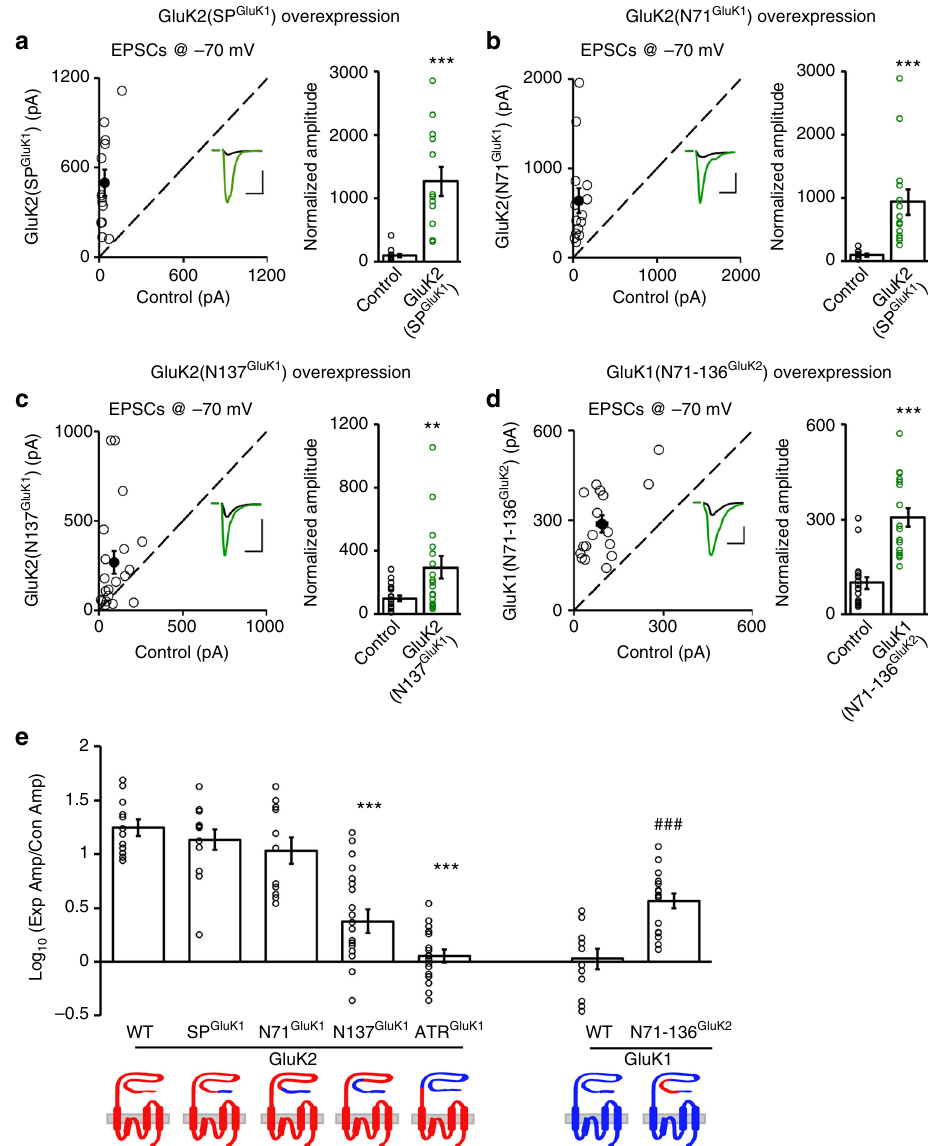
Fig. 3 GluK1 ATD is required to restrain its synaptic targeting. a – d The eEPSCs measured at − 70 mV for chimera receptors biolistically expressed in CA1 neurons vs. neighboring control neurons. The scale bars for representative eEPSC traces were 200 pA/25ms for a , b and 100 pA/25 ms for c , d . Bar graphs show normalized eEPSC amplitudes (mean ± SEM) presented in scatter plots ( a GluK2(SP GluK1 ), n = 13, 1270.14 ± 222.55% control, *** p < 0.0005; b GluK2(N71 GluK1 ), n = 14, 939.65 ± 204.54% control, *** p < 0.0001; c GluK2(N137 GluK1 ), n = 20, 1270.14 ± 296.59% control, ** p < 0.005; d GluK1(N71- 136 GluK2 ), n = 17, 305.77 ± 29.94% control, *** p < 0.0005.) Statistical analyses are comparisons between transfected neurons and respective control neurons using two-tailed Wilcoxon signed-rank sum test. e Bar graph shows logarithm summary of the eEPSC amplitude ratios (mean ± SEM) between the experimental and respective control neurons for the indicated transfections (GluK2: 1.25 ± 0.07; GluK2(SP GluK1 ): 1.14 ± 0.10; GluK2(N71 GluK1 ): 1.03 ± 0.12; GluK2(N137 GluK1 ): 0.38 ± 0.11; GluK2(ATR GluK1 ): *** p < 0.0001 compared to wild-type GluK2. GluK1: 0.03 ± 0.10; GluK1(N71-136 GluK2 ): 0.57 ± 0.07; ### p < 0.0005). It should be noted that the raw data of GluK1, GluK2 and GluK2(ATR GluK1 ) are re-used from our previous study 15 . The schematic cartoons for the swapped domains between GluK1 (blue) and GluK2 (red) proteins are shown below the graph. Data in e are analyzed using Mann – Whitney U (Fig. 2f). Thus, we used HA-SP GluK1 -GFP to test its binding capability to FLAG-tagged GluK1 or GluK2 ATD, in which the GluK2 signal peptide was used to ensure its expression in the ER pathway (Fig. 4a). These fusion proteins could be recog- nized based on their expected sizes with anti-HA or anti-FLAG antibody, respectively (left panels in Fig. 4a). After coexpression in HEK cells, HA-SP GluK1 -GFP could ef fi ciently pull-down ATD GluK1 -FLAG, but was weakly co-immunoprecipitated with ATD GluK2 -FLAG (lanes 4 and 5 of right panel 1 in Fig. 4a). Furthermore, a control construct lacking GluK1 signal